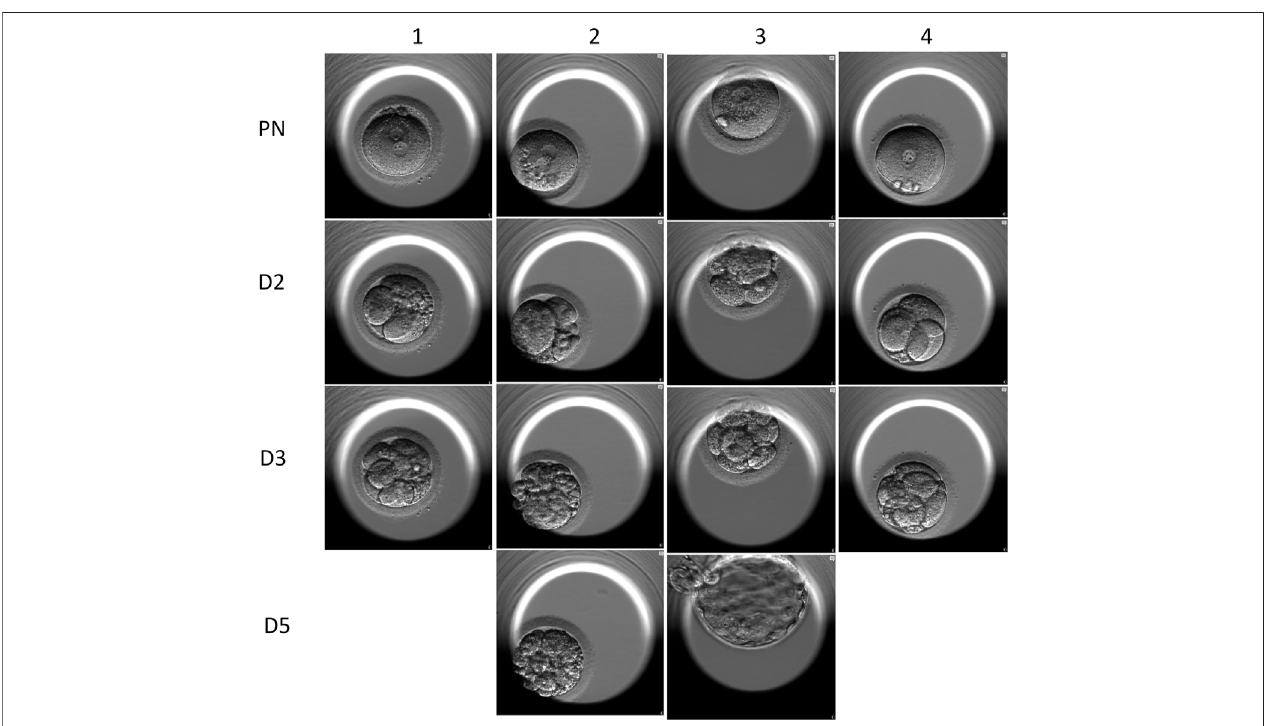
FIGURE 6 | Time-lapse images of the embryos of the ICSI cycles. Line 1 shows that the four embryos all carried 2 PN. Line 2 shows the 2-day embryos, and the embryo scores were 421, 243, 512, and 411. Line 3 shows the 3-day embryos, and three of the four embryos were quali fi ed as good quality. Line 4 shows the two transferred